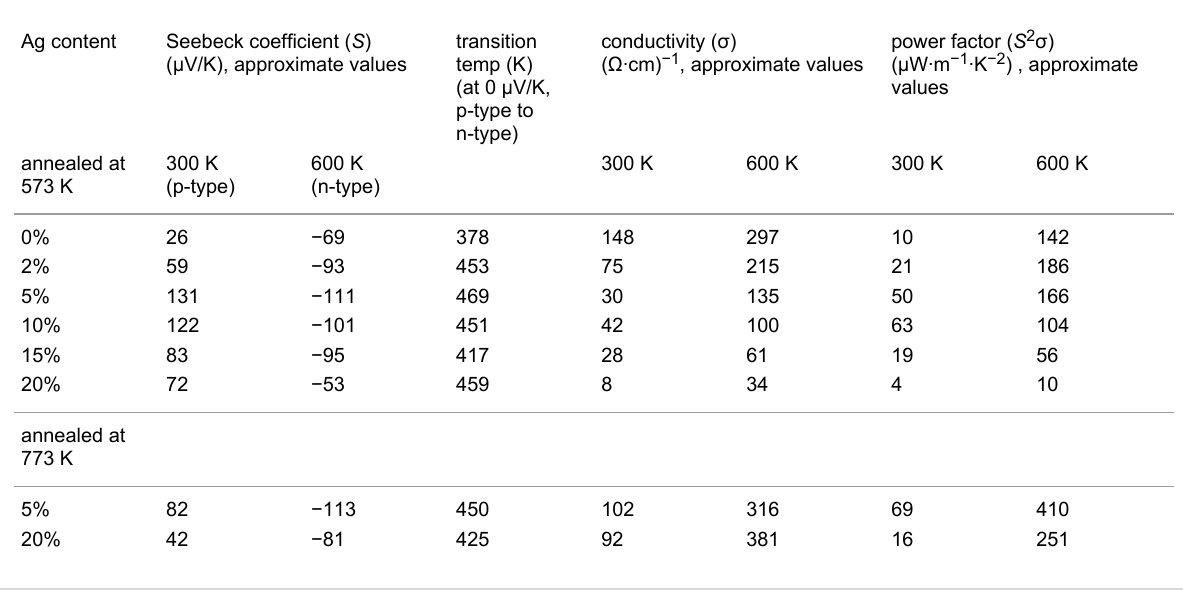
Table 1: Comparison of electrical conductivity ( σ ), Seebeck coefficient ( S ) and power factor ( S 2 σ ) at 300 and 600 K of all samples.